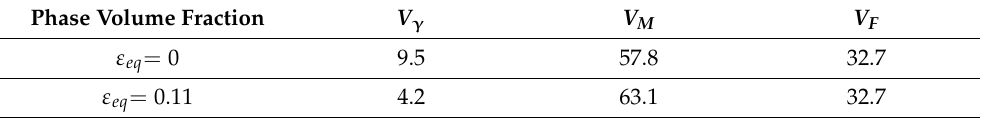
Table 2. Fractions of phase volume (%) of the QP980 steels ( 𝜀 (cid:3032)(cid:3044) = 0 and 𝜀 (cid:3032)(cid:3044) = 0.11). Phase Volume Fraction